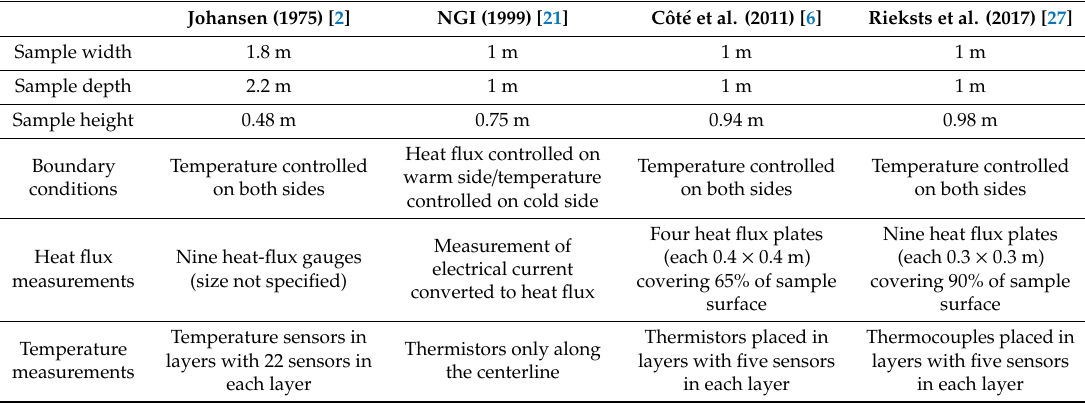
Table 2. Summary of experimental laboratory test setups.